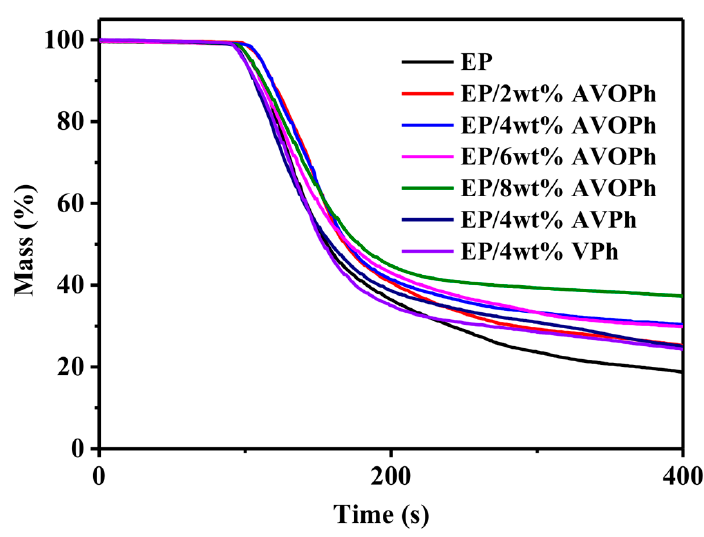
Figure 5. Mass loss curves of pure EP and its composites at CCT.